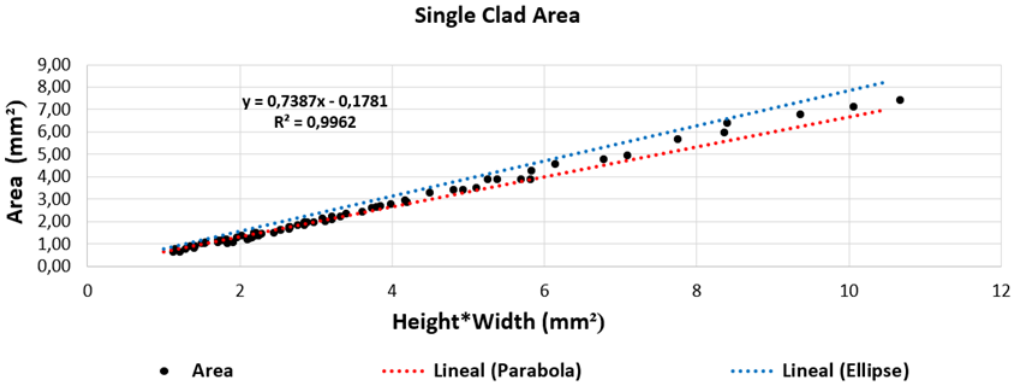
Figure 9. Comparison of the clad areas, using a continuous nozzle with the area of a second-degree parabola (Area = 2·(Height·Width)/3) and an ellipse (Area = Π·(Height·Width)/4).